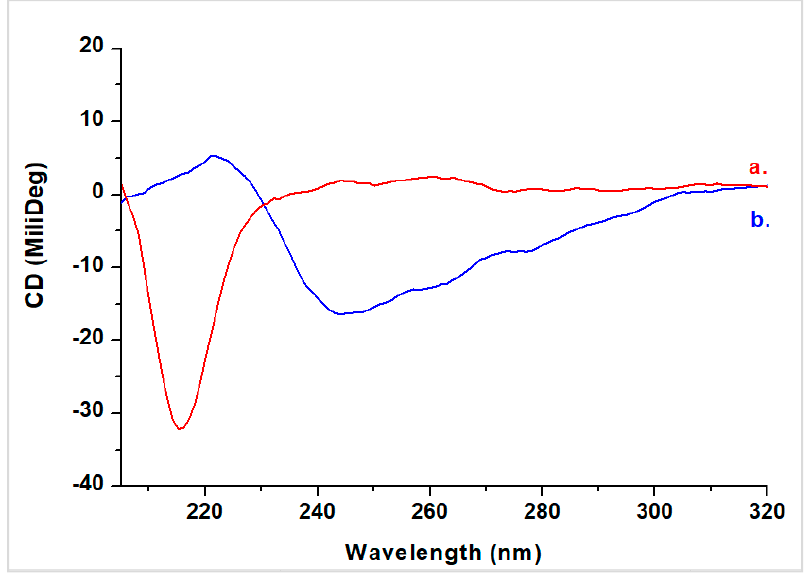
Figure 13. Circular dichroism spectra of ( a ) chiral ligand ( 4 ) and ( b ) chiral PMO NPs.